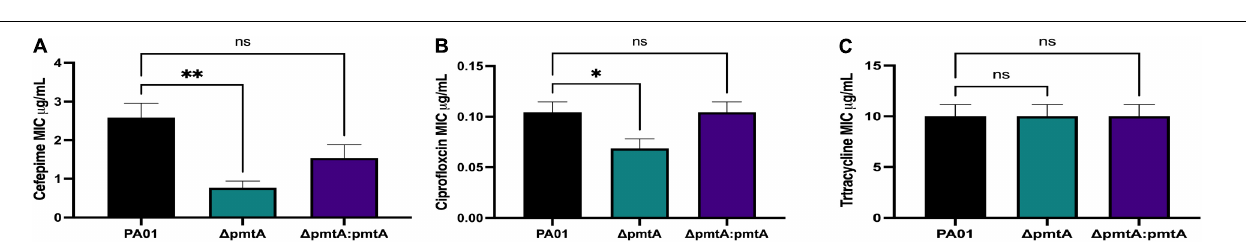
with (cid:49) pmtA:pmtA and wild-type was less than 20%. These data indicate a role for PmtA in the virulence of P.